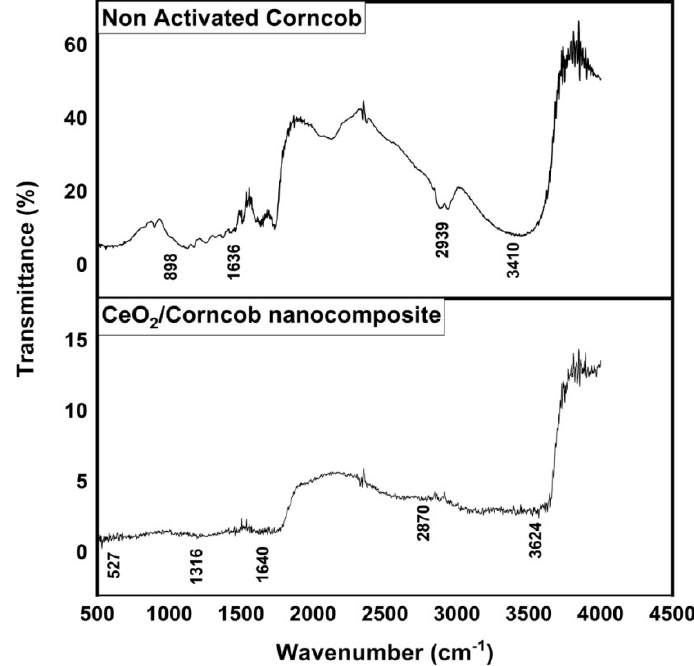
Figure 3. FTIR spectra of the corncob and CeO 2 /corncob nanocomposite.